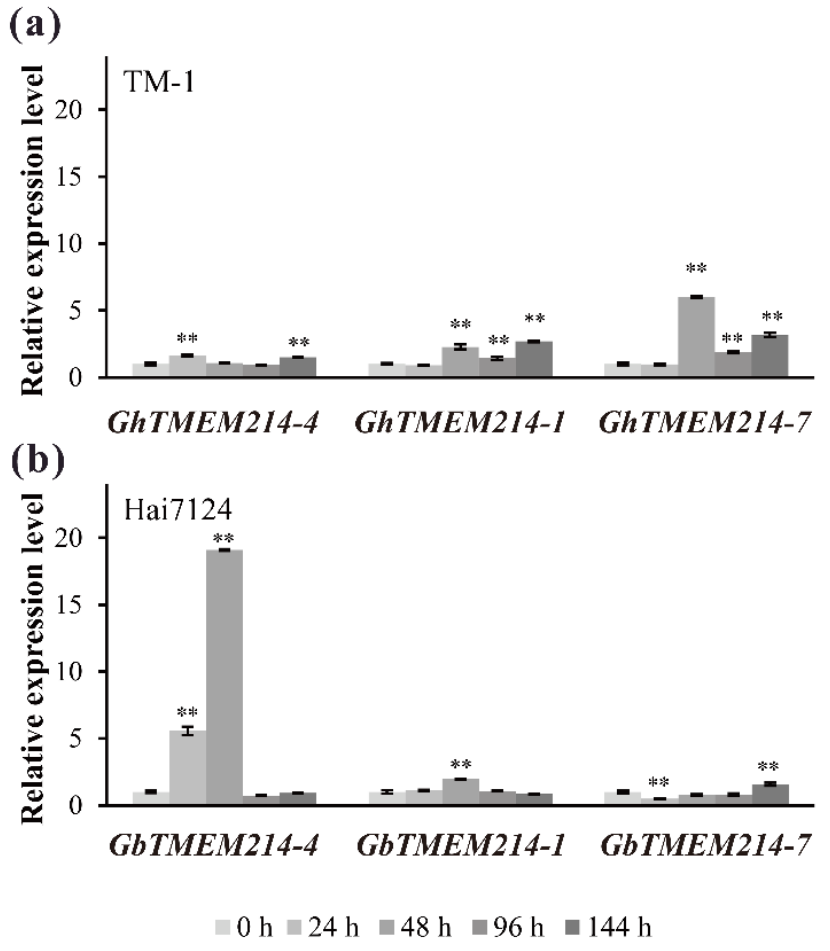
Figure 5. The relative expression levels of TMEM214 genes under the challenge of V. dahliae . ( a ) GhTMEM214 genes in susceptible variety TM-1; ( b ) GbTMEM214 genes in resistant variety Hai7124. The qRT-PCR was applied to analyze the expression of TMEM214 genes. The data were expressed relative to 0 h for each gene. “**” represent significant differences relative to each control and p -value < 0.01, based on Student’s t -test. Each value was the mean ± SD of three biological determinations.